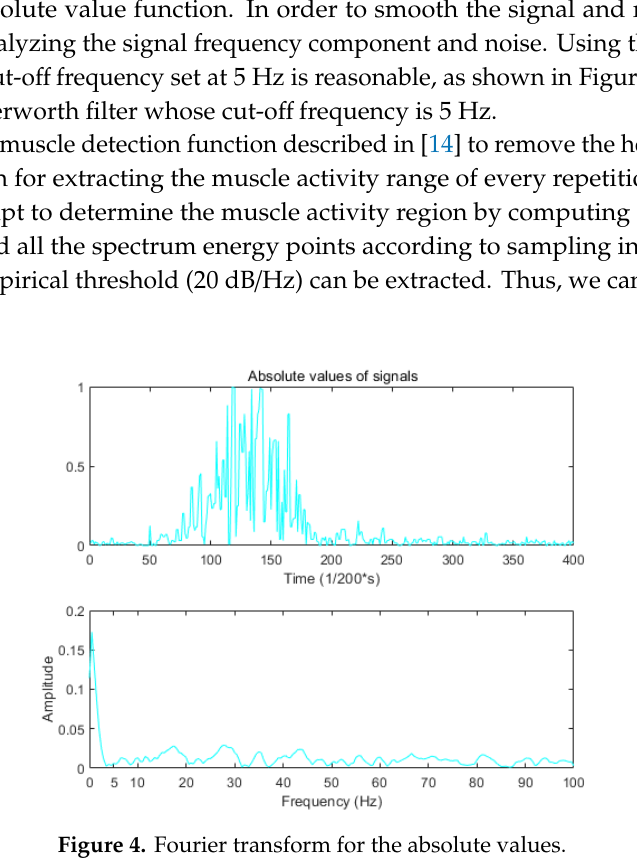
Figure 3. Original surface electromyography (sEMG) signals recorded by the MYO armband.